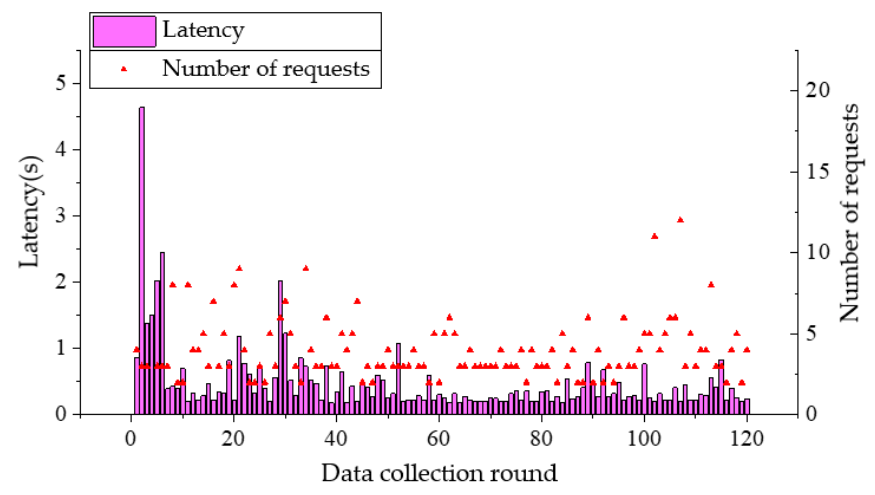
Figure 16. Communication latency of node A and the number of requests from UAV when flight altitude is 10 m.